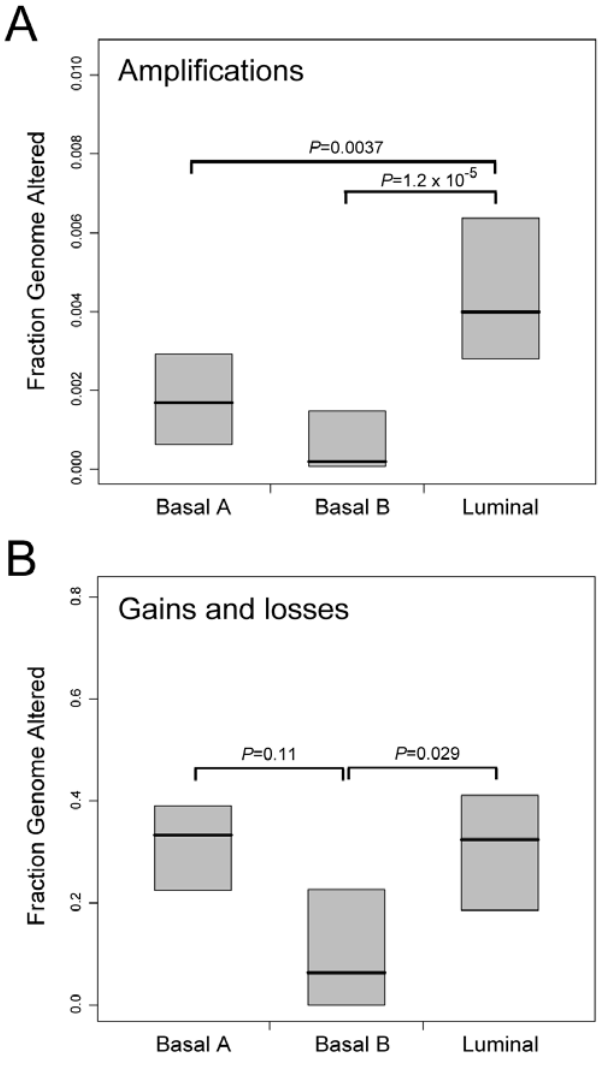
Figure 4. Cell line subtypes exhibit distinct genomic instabil- ities. Fraction of genome comprising (A) high-level DNA amplification; or (B) low-level gain/loss, stratified by cell line subtype (luminal, basal- A, basal-B). Box plots show 25 th , 50 th and 75 th percentiles; P -values (Students t -test) for pairwise comparisons are shown.